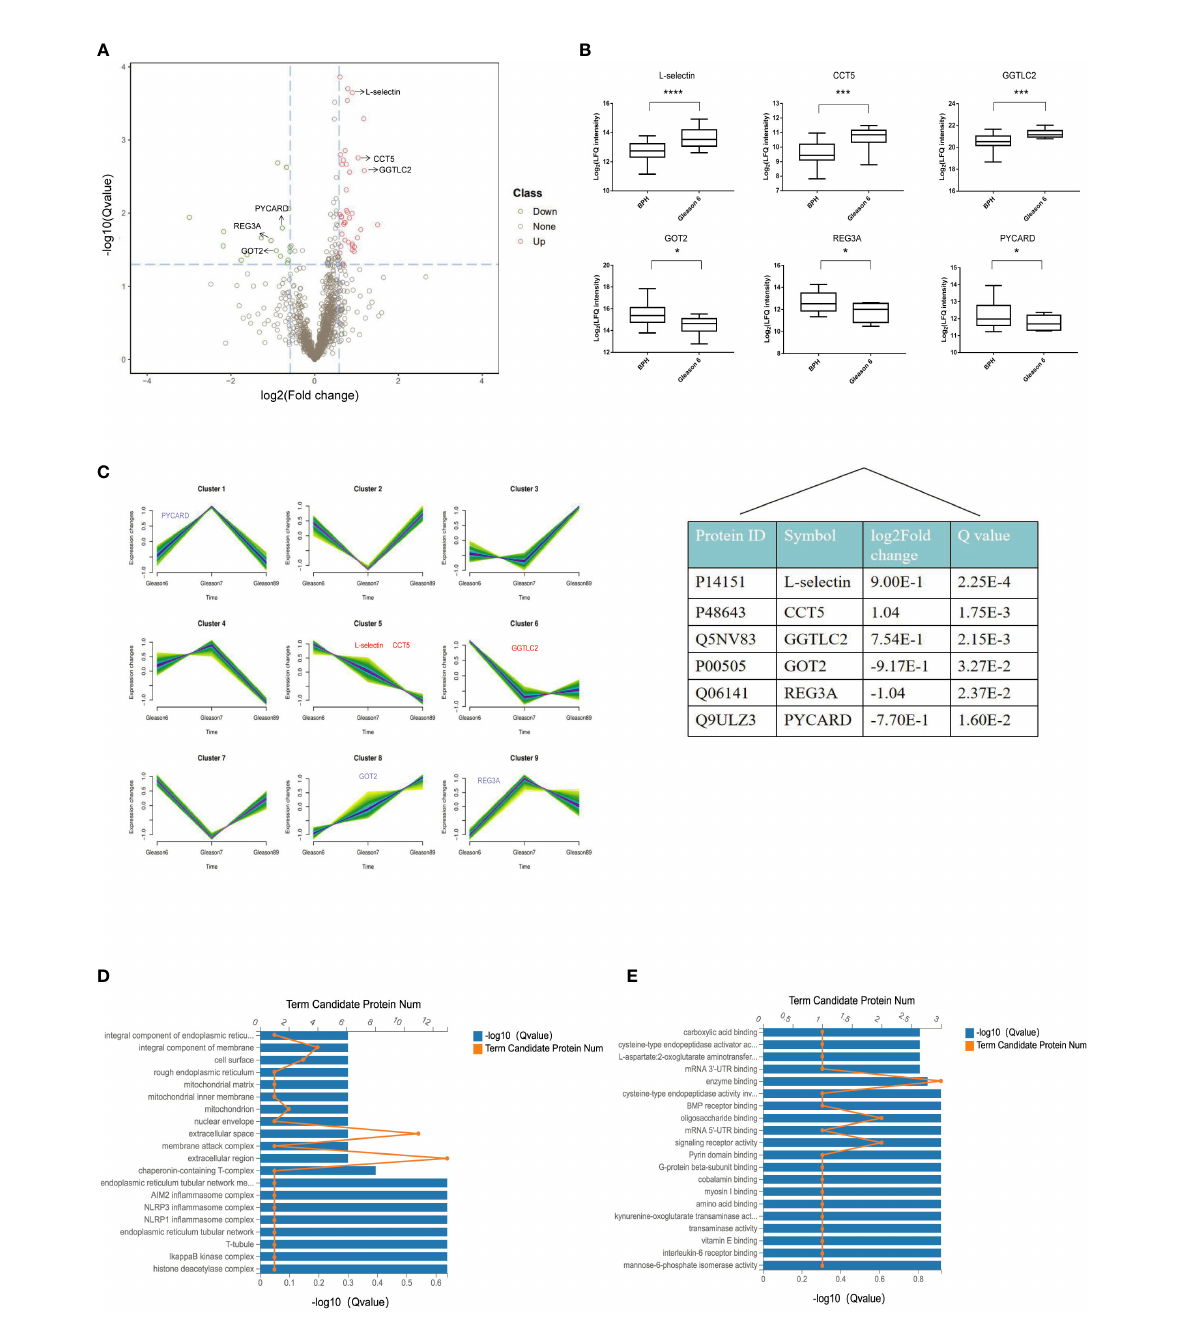
FIGURE 4 Quantitative differential analysis between early-stage PCa and BPH patients. (A) Volcano map of the DEPs between BPH and Gleason 6 patients. Red and green dots represent up- and down-regulated proteins, respectively. (B) Box plot analysis of intensity values for DEPs. (* p <0.05, *** p <0.005, **** p <0.001). (C) The patterns of dynamic changes in DEPs during the progression of PCa analyzed by Fuzzy c-means clustering. The X-axis represents different Gleason scores of PCa, and the Y-axis represents log2-transformed intensity values in each cluster. (D) GO cellular component enrichment histogram. The column length of the X-axis below represents the size of the Q value[-log10(Q value)] and the value of points on the broken line on the top X represents the number of differential proteins annotated to this GO Term. (E) GO molecular function enrichment